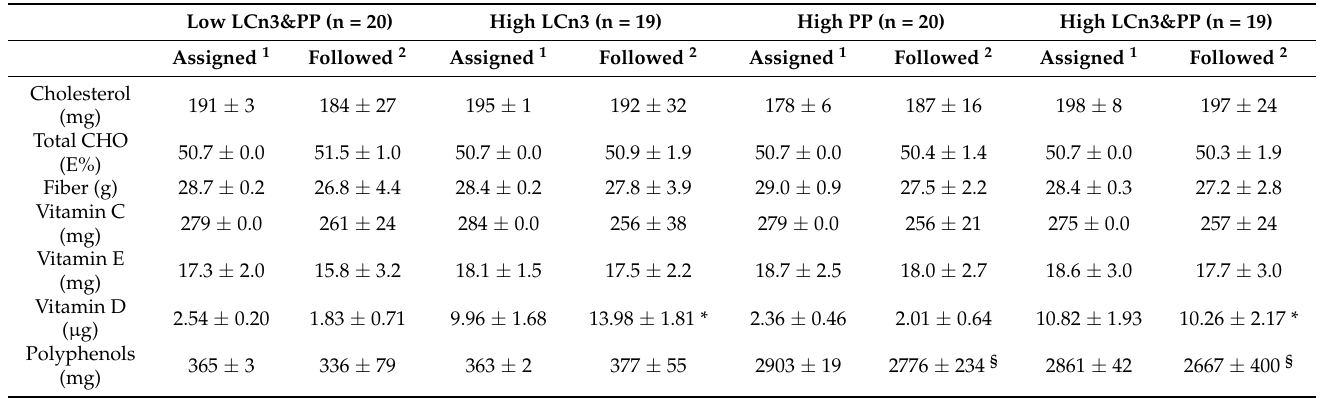
Table 2. Baseline characteristics and inflammatory markers concentrations of the four groups of participants in the dietary intervention study.